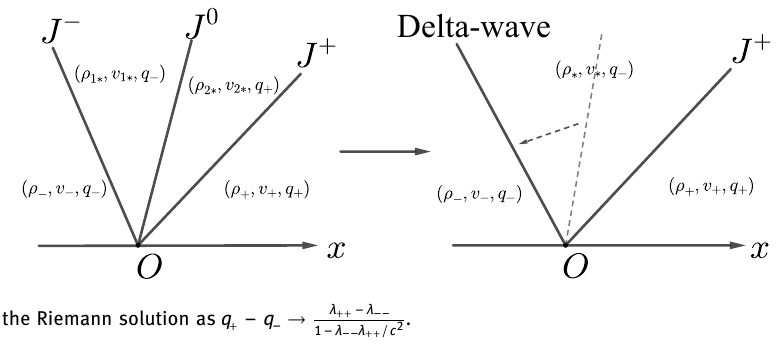
Figure 5: Limit of the Riemann solution